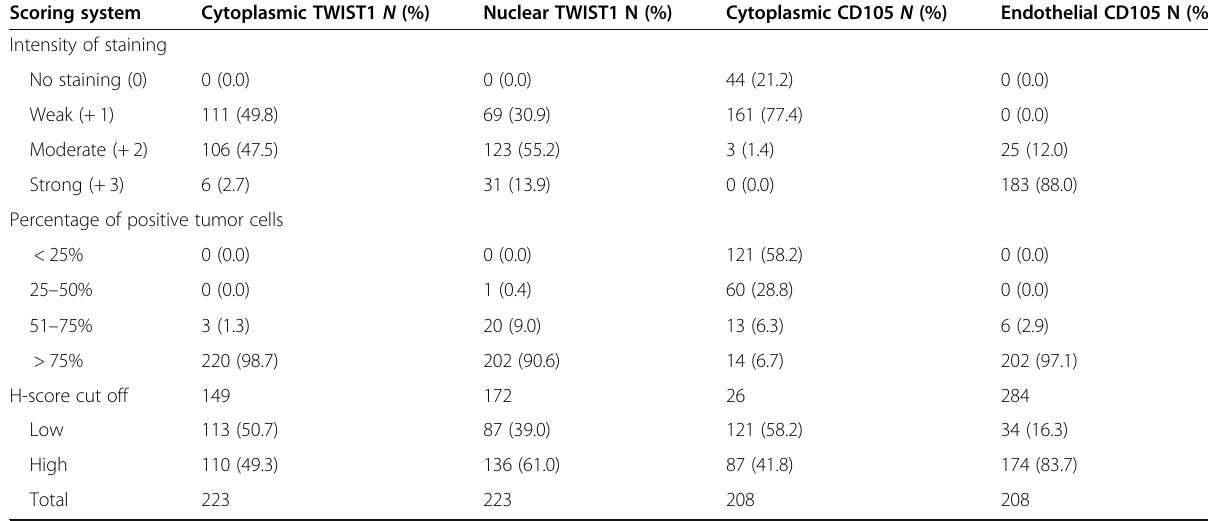
Table 2 TWIST1 and CD105 expression (Intensity of staining, percentage of positive tumor cells, and H-score) in colorectal cancer (CRC) samples